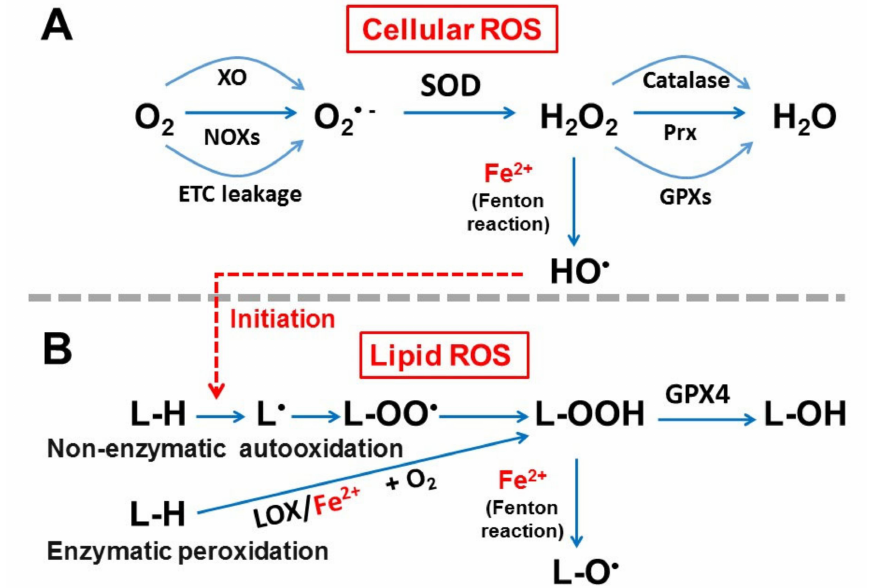
Figure 3. Generation of cellular ( A ) and lipid ( B ) ROS. See text for details. XO: xanthine